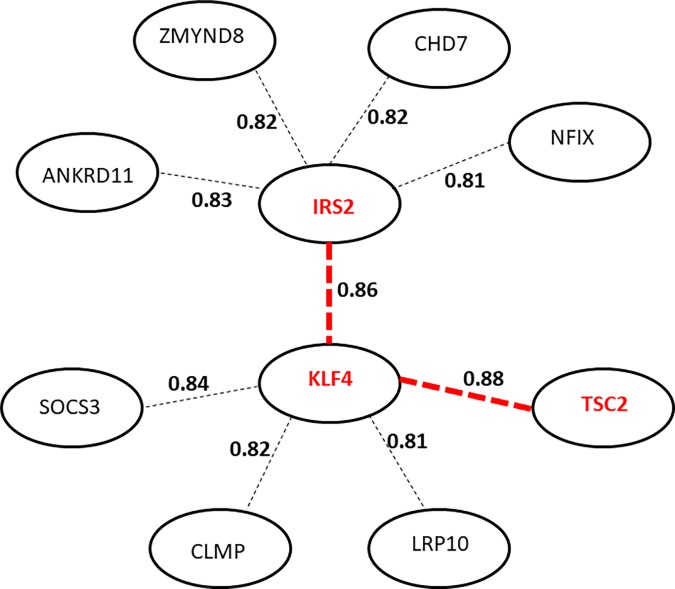
Reverse application of BAKE.Network expansion around IRS2 identified 5 neighbors (connected to IRS2 through dotted edges) that are transcriptional regulators. The degree of correlation between the gene expression profiles across the four conditions (DC8, DC16, DW8 and DW16) are shown as numbers on the edges connecting the genes. The network around KLF4, the strongest neighbor of IRS2, was similarly expanded as for IRS2 to rediscover IRS2 as one of KLF4’s neighbor along with TSC2, KLF4’s strongest neighbor. The edges connecting KLF4, IRS2 and TSC2, are highlighted in red to mark their strong associations. Note that the correlation coefficient between the expression profiles of TSC2 and IRS2 was also remarkable with 0.76 (not shown).